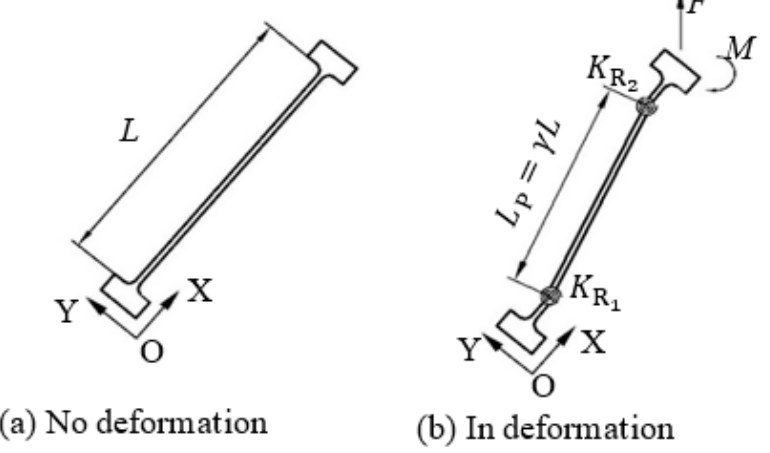
Figure 5. Pseudo-rigid-body model (PRBM) of the inverted compliant Figure 5 PRBM of the inverted compliant beam.